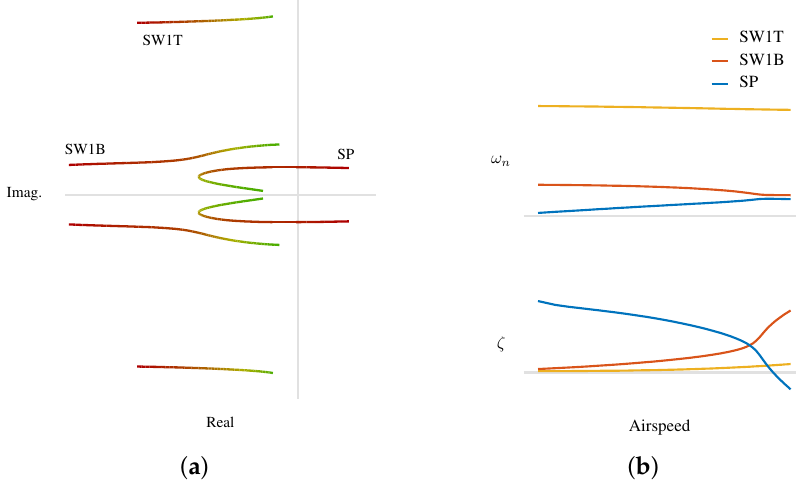
Figure 10. Variation in modal characteristics of the identified model with airspeed and dynamic pressure: ( a ) dynamic-pressure root locus of the identified model, with dynamic pressure increasing linearly from about 15% of the flutter speed (green) to about 115% of the flutter speed (red); and ( b ) frequency and damping ratio of eigenvalues for the identified model over the same airspeed